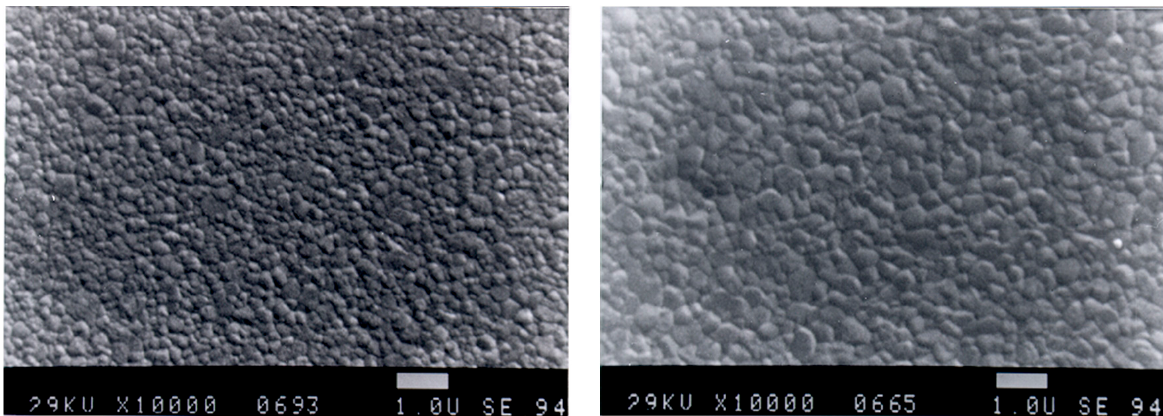
Figure 17. Microstructure of Y-TZP derived by coating ( left ) and coprecipitation ( right ) method (magnification 10,000×)